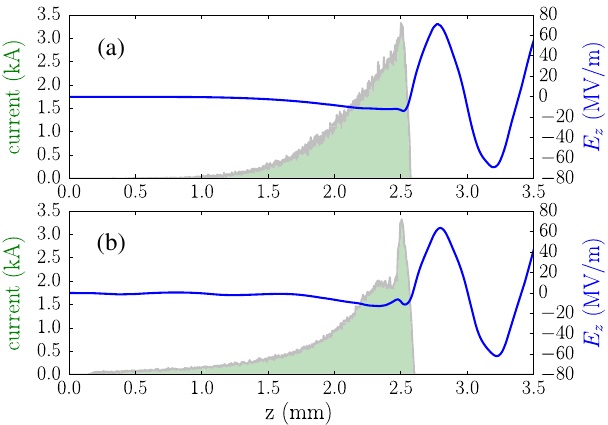
FIG. 9. Final current distribution (green shaded area) and associated wakefield (blue traces) for the “ ideal ” (a) and “ realistic ” (b) cases of compression discussed in the text. The head of the bunch corresponds to z ¼ 0